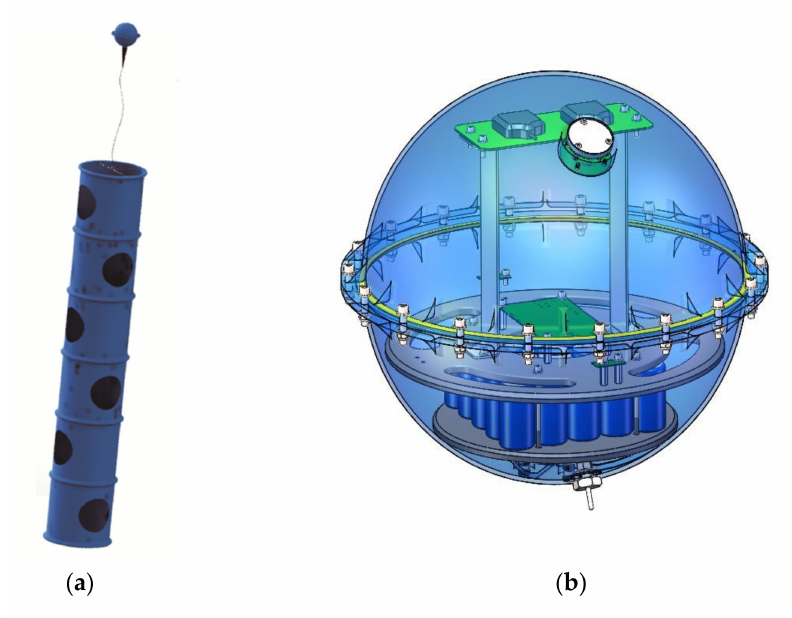
Figure 1. BUOY-41 ( a ) overall structure; ( b ) internal